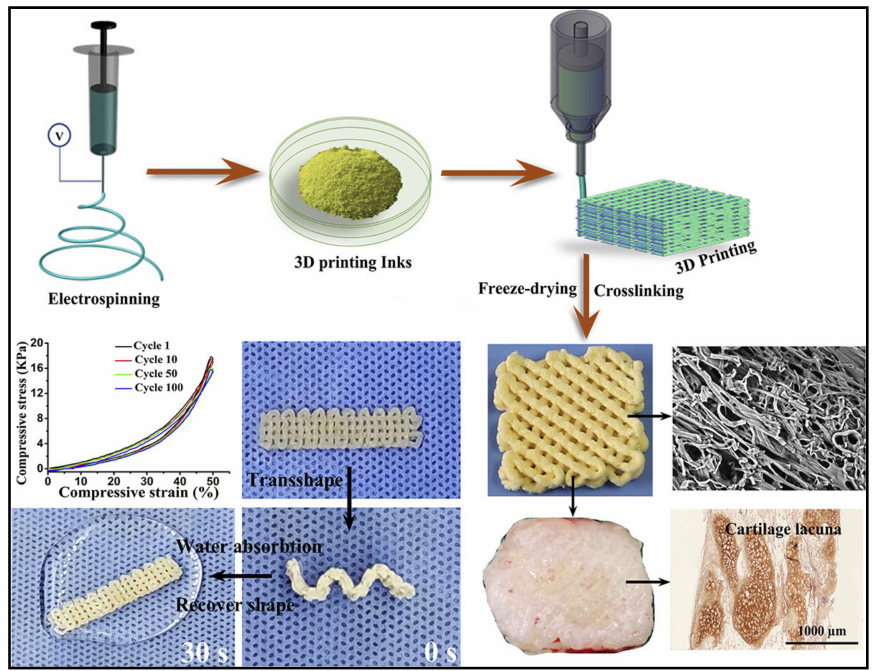
Figure 6. Schematic illustration of 3D printed electrospun scaffold for cartilage regeneration. Adapted with permission from ref. [137]. 2019